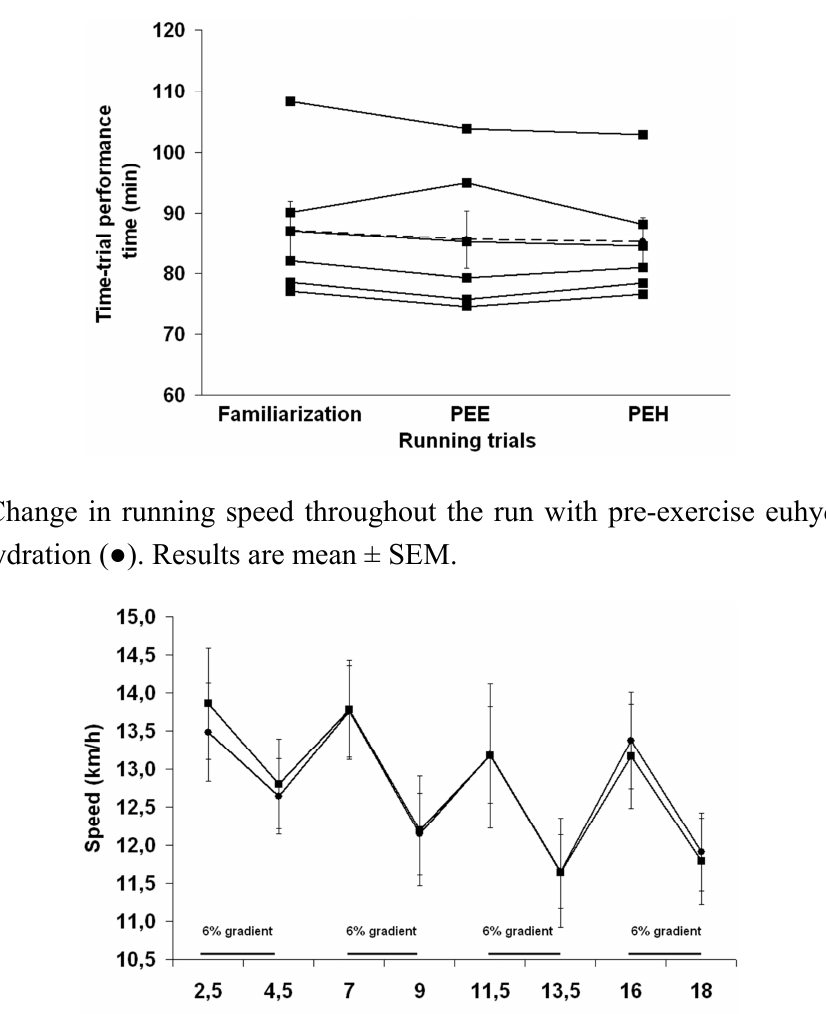
Figure 3. Individual time-trial performance time during the familiarization period and with pre-exercise euhydration (PEE) and hyperhydration (PEH). The dashed line represents the mean (±SEM) time-trial performance time observed in each of the three running trials.